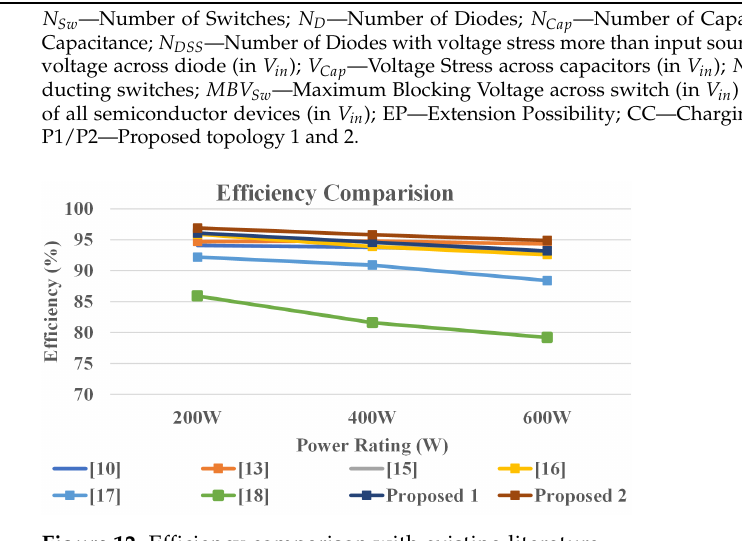
Figure 12. Efficiency comparison with existing